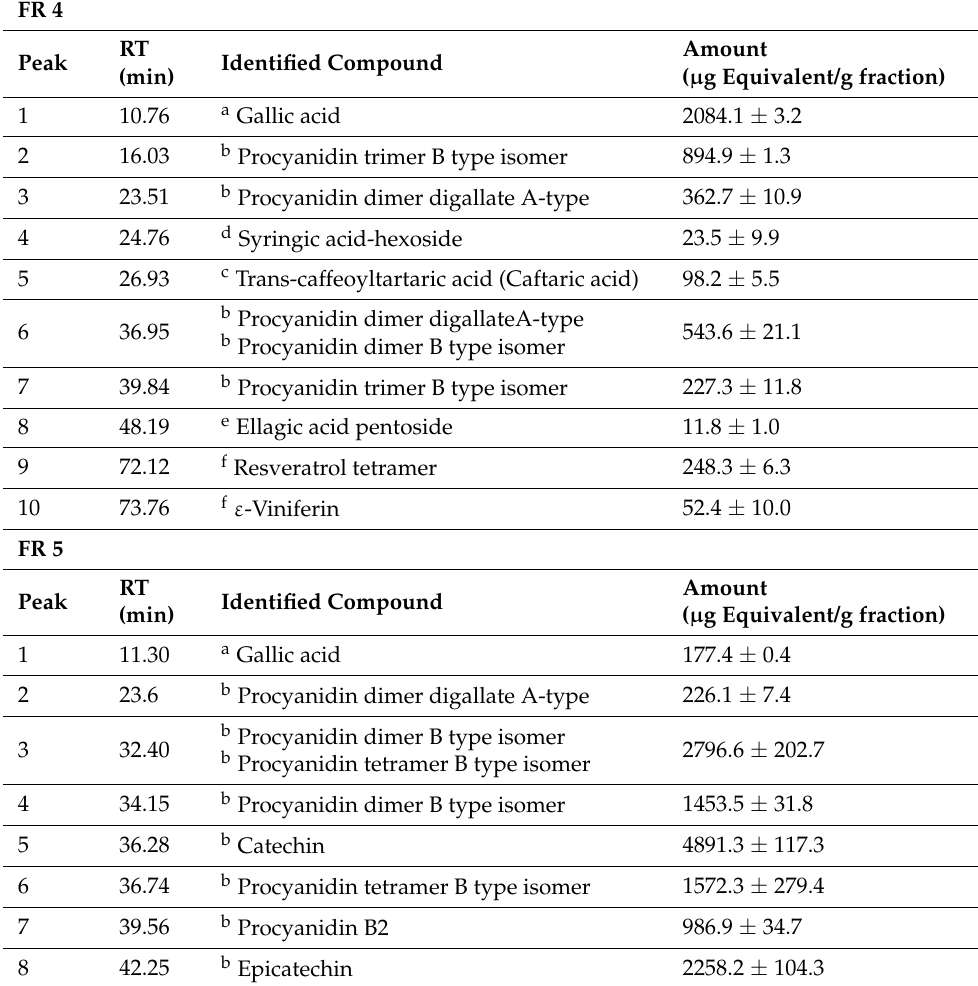
Table 2. Identification and quantification of the main phenolic compounds in FR 4 and FR